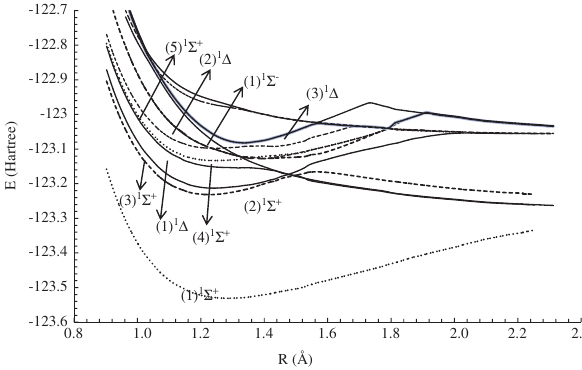
Figure 4: Potential energy curves of the electronic states 5 Σ ± and 5 Δ of the molecule